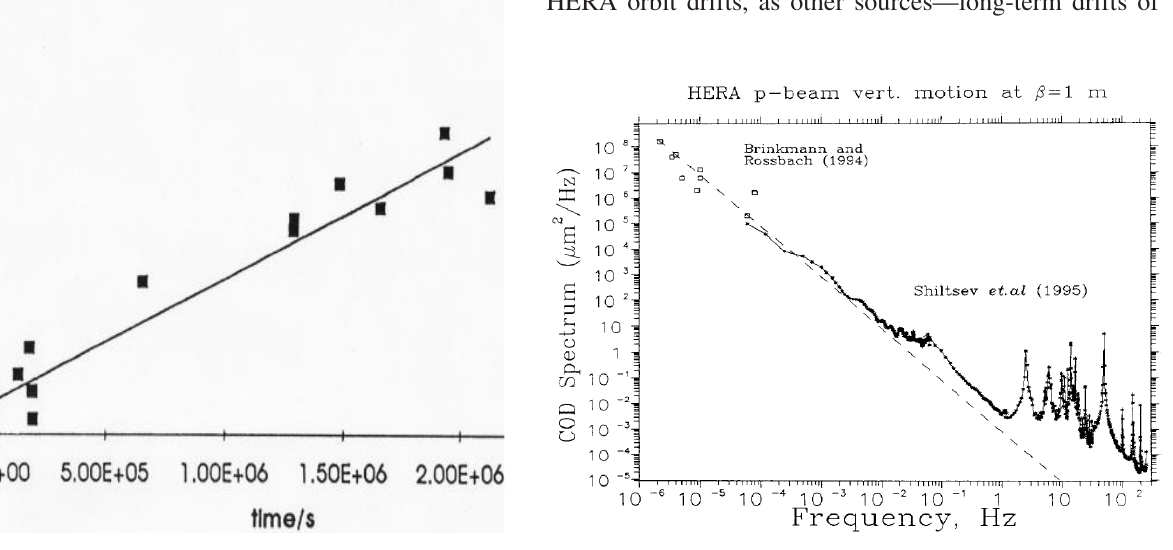
FIG. 1. (Color) Mean square difference of vertical orbit distor- tions in the HERA electron ring vs time interval duration obtained from data stored during 1993 operation data [18].